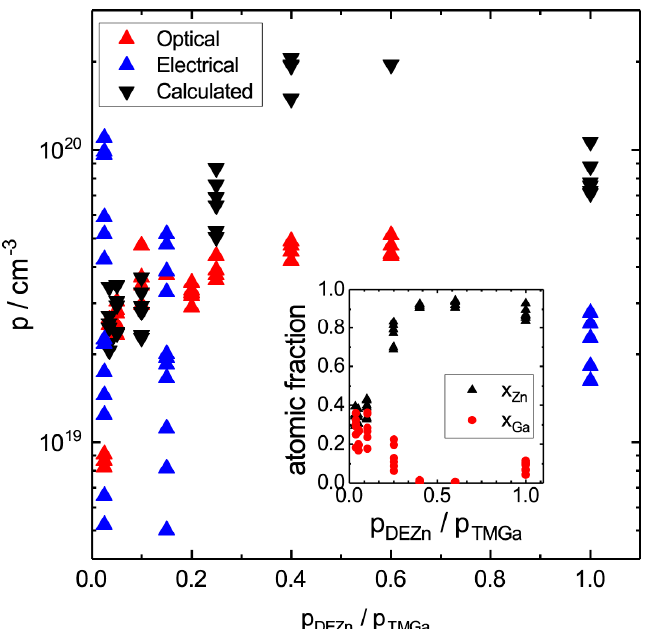
Figure 6. The p ‐ doping concentration as a function of the nominal gas phase ratio of Zn and Ga precursors, p DEZn / p TMGa , during aerotaxy growth. The red and blue triangles account for optically and electrically measured doping concentrations, respectively. The black downward pointing triangles represent calculated doping concentrations based on the atomic fractions measured by EDS and shown in the inset, x As = 0.01, x Au = 1 − x As − x Ga − x Zn , and T = 550 ◦